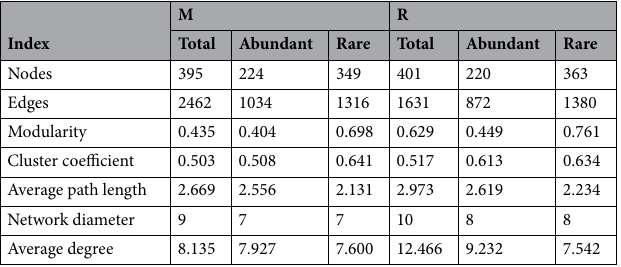
Table 3. The soil bacterial network properties in different cropping patterns of tobacco. M tobacco monoculture, R tobacco-rice rotation, Total whole bacterial communities, Abundant abundant taxa, Rare rare taxa.